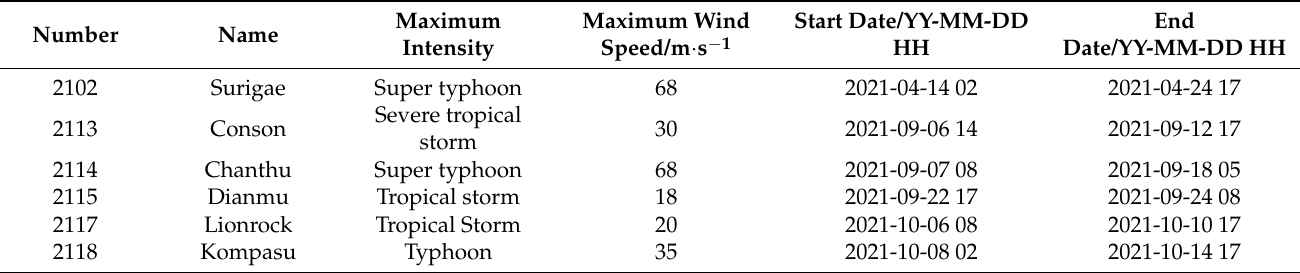
Table 1. Typhoons and tropical storms generated in or passing through the SCS in April, September and October